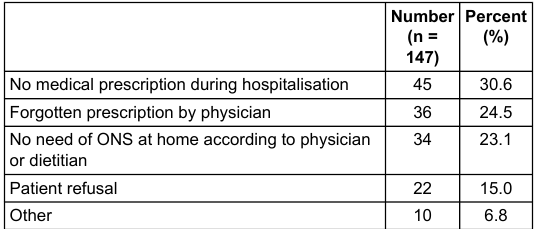
Table 2: Reasons for absence of oral nutritional supplement (ONS) prescription at discharge for home.